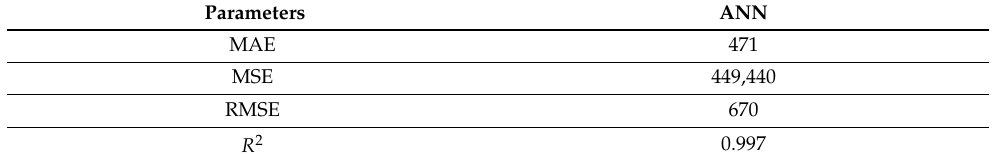
Table 11. Results by ANN for water consumption prediction.